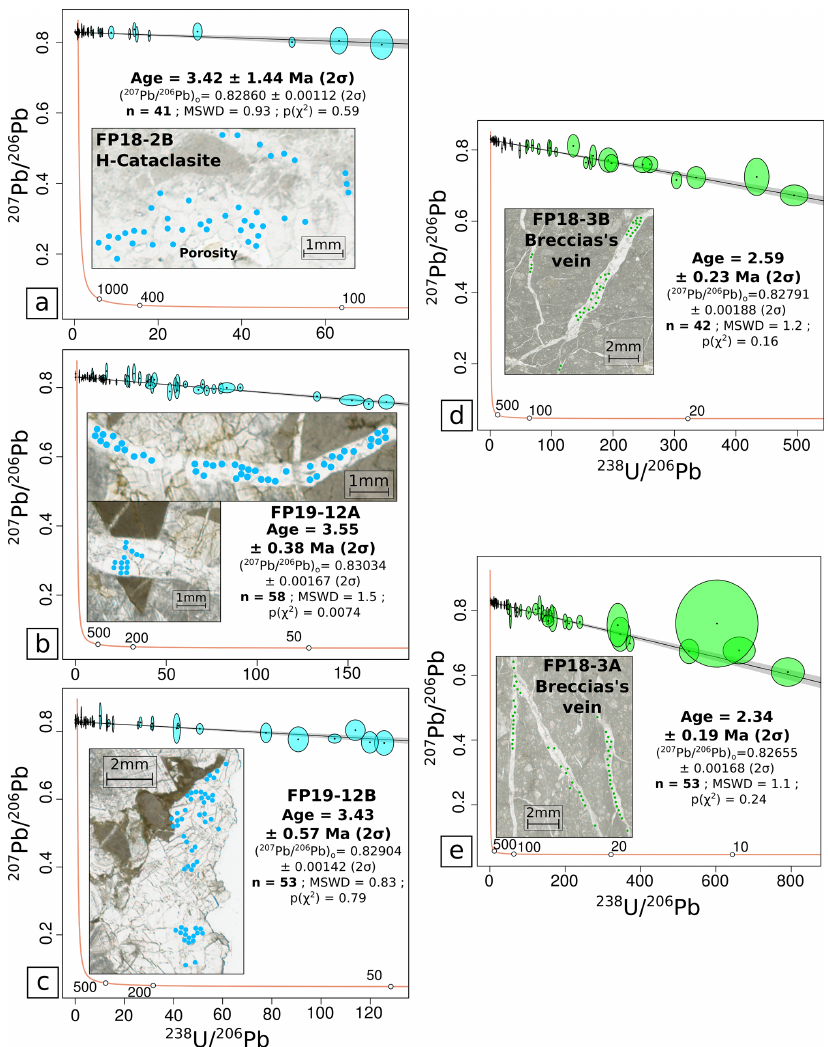
Figure 7. Tera-Wasserburg concordia plot of (a) highly cataclased sample FP18-2 calcite filling, (b, c) sample FP19-12A veins and FP19-12A “clean calcite” filling, and (d, e) sample FP18-3 veins and corresponding maps of sampled spots (150µm). MSWD: mean square weighted deviation. An additional error propagation tied to WC-1 standard uncertainty is taken into